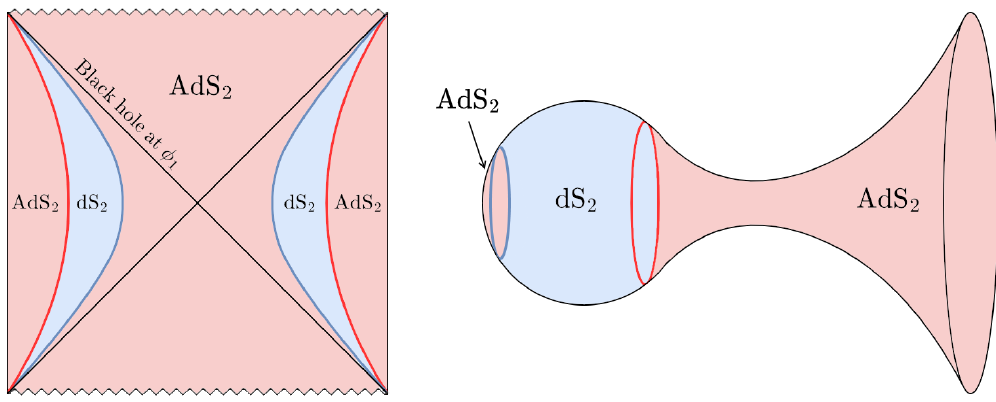
Figure 6 . Left: Penrose diagram of the double interpolating geometry. Right: corresponding Euclidean